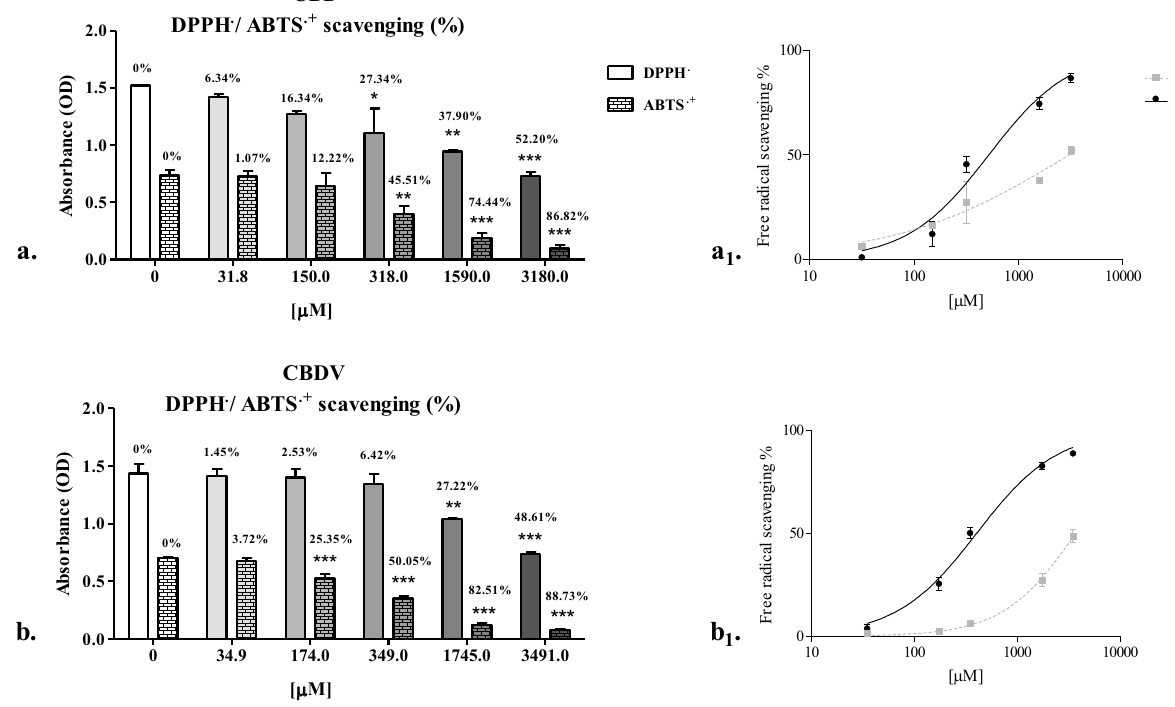
Figure 5. DPPH /ABTS+ scavenging (%). DPPH/ABTS+ scavenging (%) at different concentrations (µM) of CBD ( a ) and CBDV ( b ) as determined by DPPH and ABTS assays. The results are expressed as the means ± standard deviations obtained from five independent experiments. Dunnett’s multiple comparison test was performed with OD values of the negative control (0 µM) and all other tested concentrations: *p < 0.05, **p < 0.001, ***p < 0.0001. The percentage of free radicals scavenged by CBD ( a 1 ) and CBDV ( b 1 ) is reported in concentration [µM]-effect